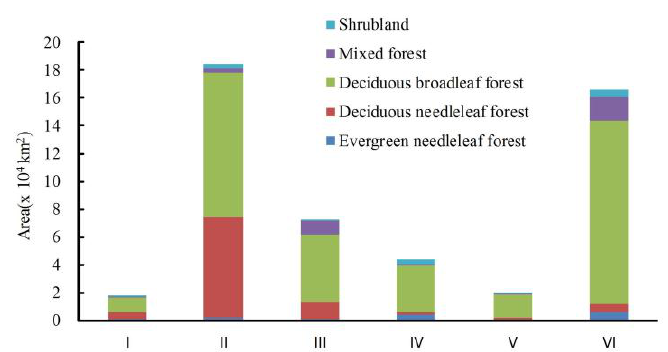
Figure 6. Forest area of ecological functional zones from HJ-1-based imagery in Northeast China. I: Hulun Buir region; II: Daxing’an Mountains; III: Xiaoxing’an Mountains; IV: Songliao Plain; V: Sanjiang Plain; VI: Changbai Mountains.